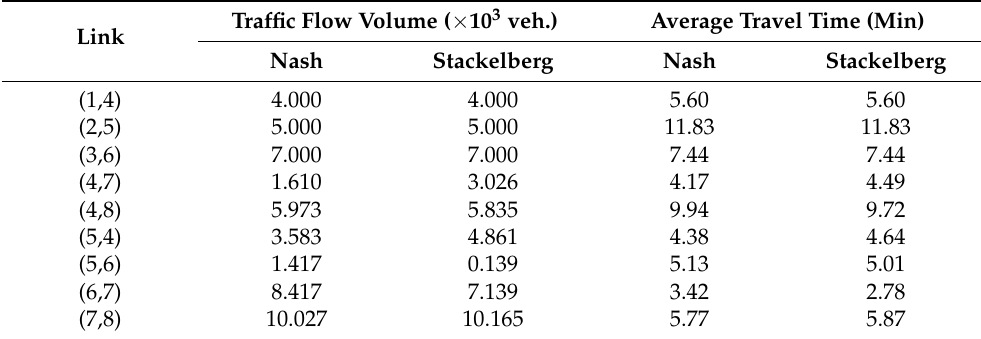
Table 4. Results of optimization with the Nash and Stackelberg approaches for road network links in scenario